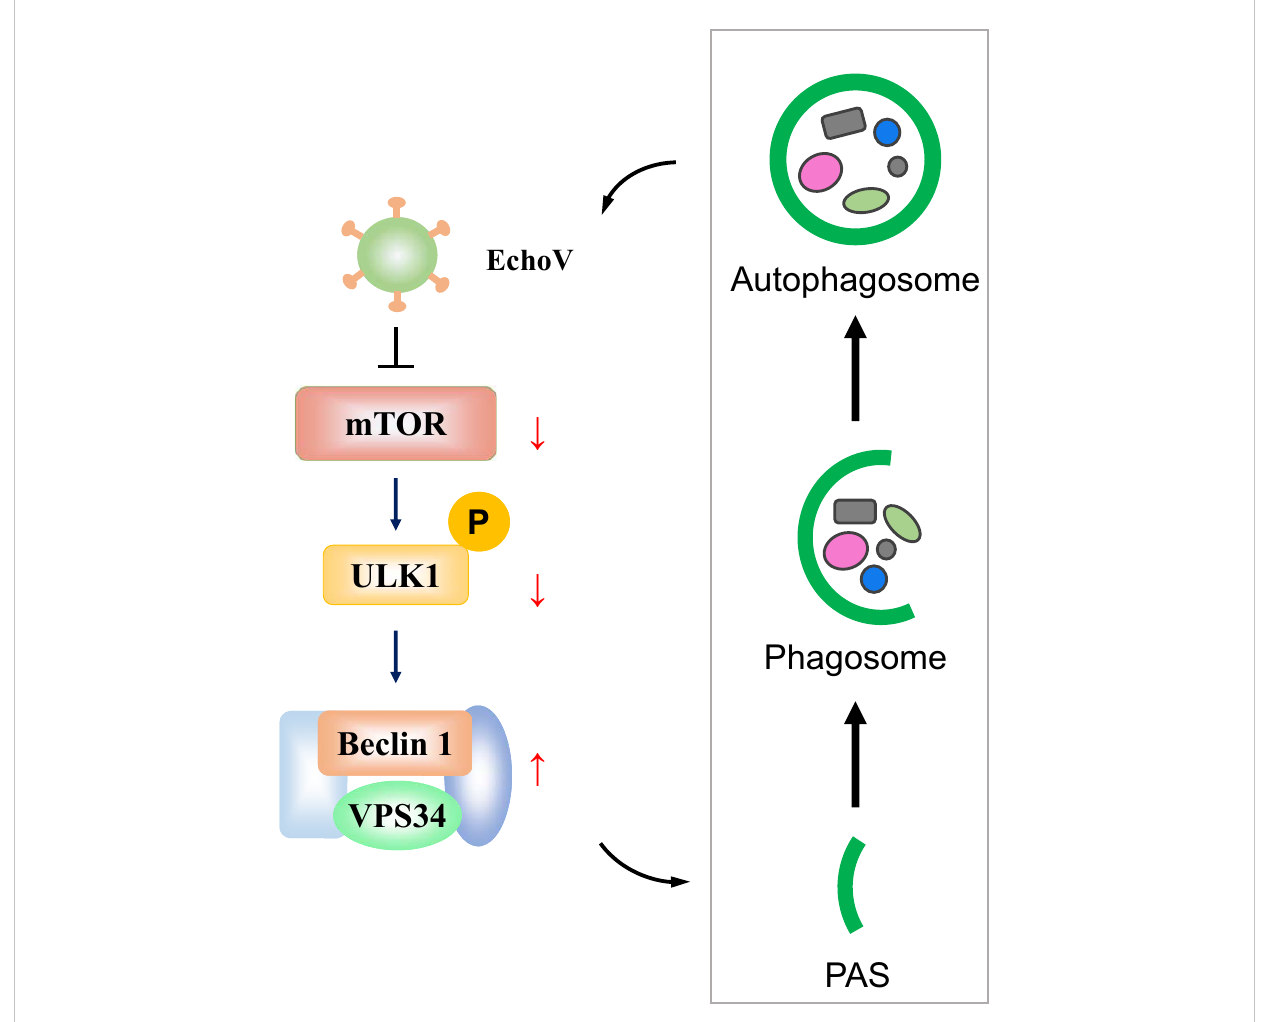
FIGURE 8 A proposed model depicting the interplay between echovirus infection and autophagy via regulating mTOR/ULK1 signaling pathway. Upon echovirus infection, the levels of phosphorylated mTOR and phosphorylated ULK1 protein on S757 decreased. Furthermore, both VPS34 and Beclin-1 protein levels increased, which promotes the formation of autophagic vesicles. Echovirus-induced autophagy promoted viral